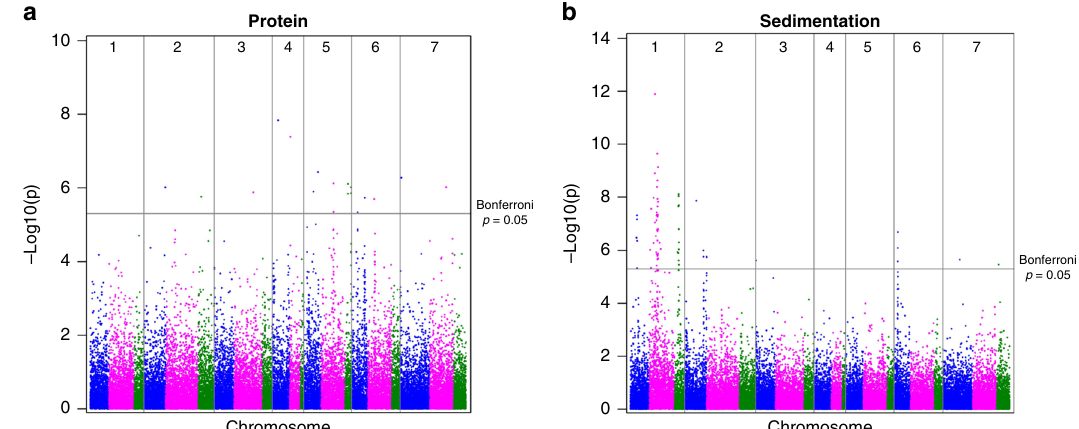
Fig. 5 Genome-wide association analysis for wheat quality characters was performed using an iterative usage of fi xed and random model circulating probability implemented by R software with correction of kinship, including the fi rst three PCA values as fi xed effects. The test was adjusted for multiple comparison in terms of P -value cutoff determination and FDR calculation. a The 18 genomic regions were associated with GPC on 12 chromosomes, with the highest peaks on 4A and 4B, followed by 5A, 5B, 7A, and 7B. b The 19 genomic regions associated with SDS on four chromosomes, 1A, 1B, and 1D, previously reported, and a QTL on